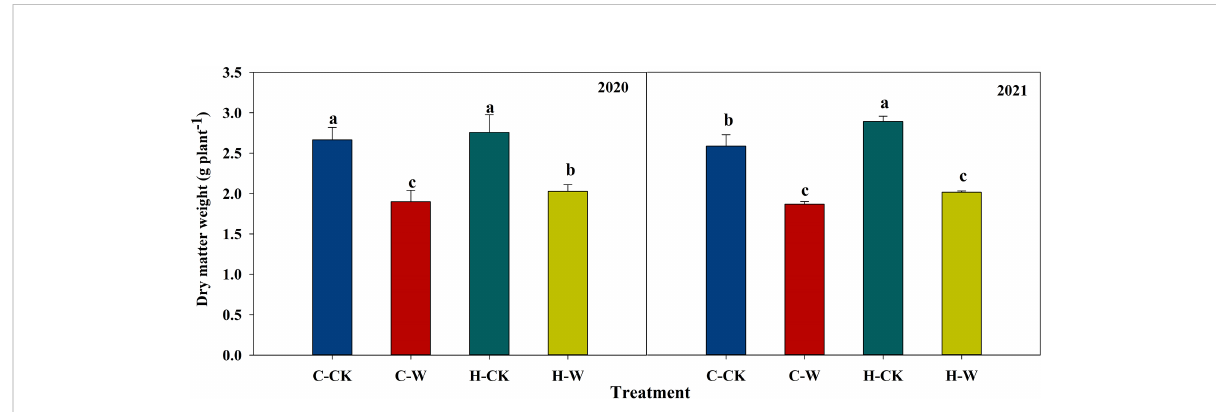
FIGURE 1 Effects of H 2 O 2 priming on dry matter accumulation of summer maize under waterlogging stress at the seedling stage. Note: C-CK: Control treatment, C-W: Waterlogging for 6 days at the V3 stage; H-CK: H 2 O 2 -priming + non-waterlogging; H-W: H 2 O 2 -priming + waterlogging for 6 days at the V3 stage. The same as